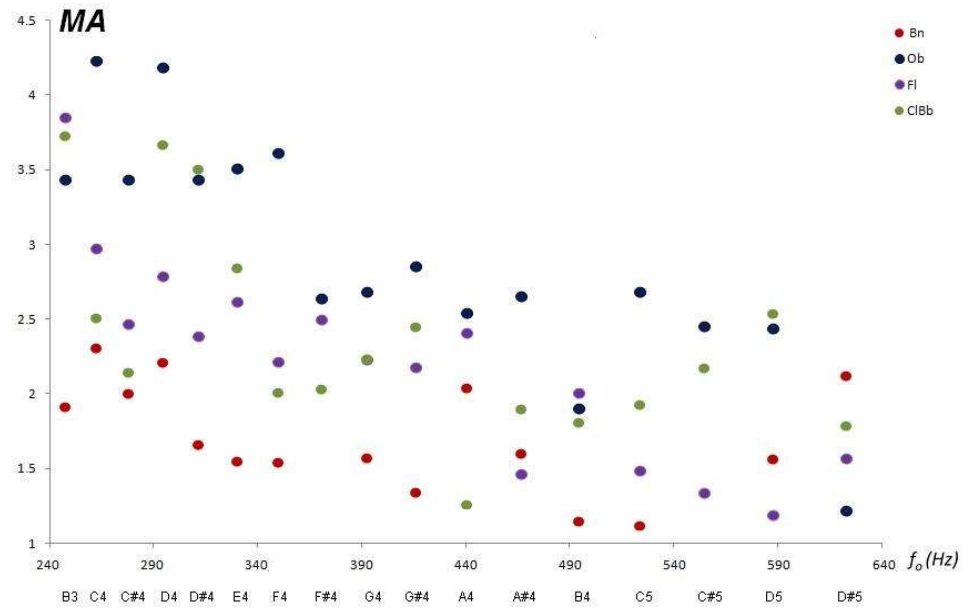
Figure 12. Variation of Mean Affinity MA in the range of sounds B3–D#5.